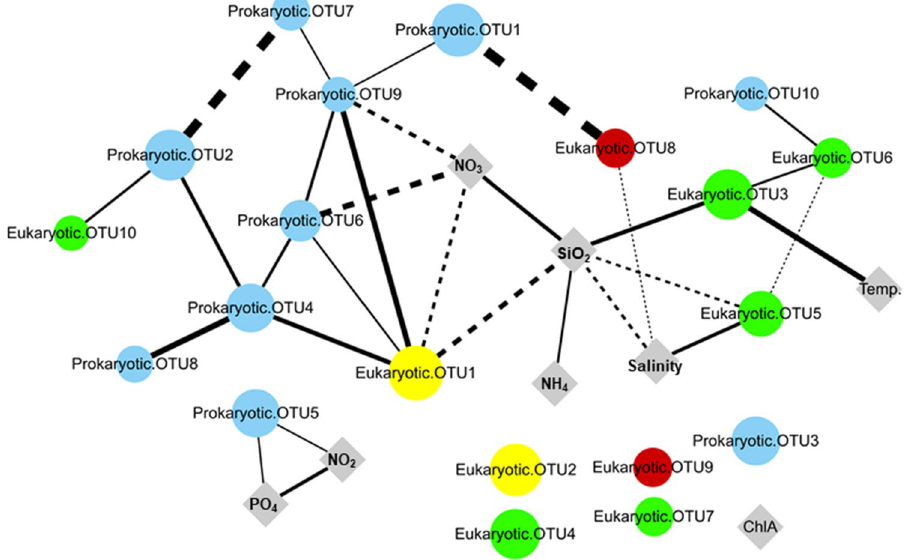
Figure 6. A microbial association network with environmental factors. In the network, each node represents the prokaryotic and eukaryotic OTUs in figure (blue circles: prokaryotic OTUs; green circles: Diatomea OTUs; yellow circles: Dinoflagellata OTUs; red circles: Ciliophora OTUs) or environmental factors in Fig. 1c (grey diamonds). The size of OTU nodes represents its sum of relative abundance, and the edges connecting the nodes (OTUs and environmental factors) represent their correlations. Of the edges, edge (line) thickness indicates the correlation coefficient (the thicker the line, the stronger correlation), and the solid lines and dotted lines represent positive and negative correlations, respectively. The isolated nodes with no edge indicate none of interaction at significant level (correlation coefficient < 0.5, P >